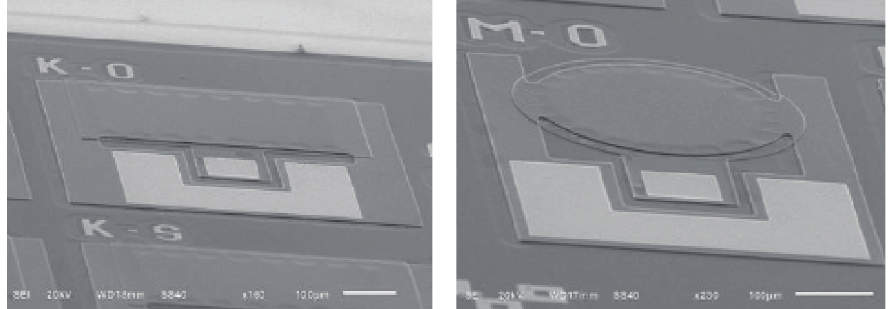
Figure 3: MEMS capacitive sensor prototypes, fabricated at the National Institute of Astrophysics, Optics and Electronics.